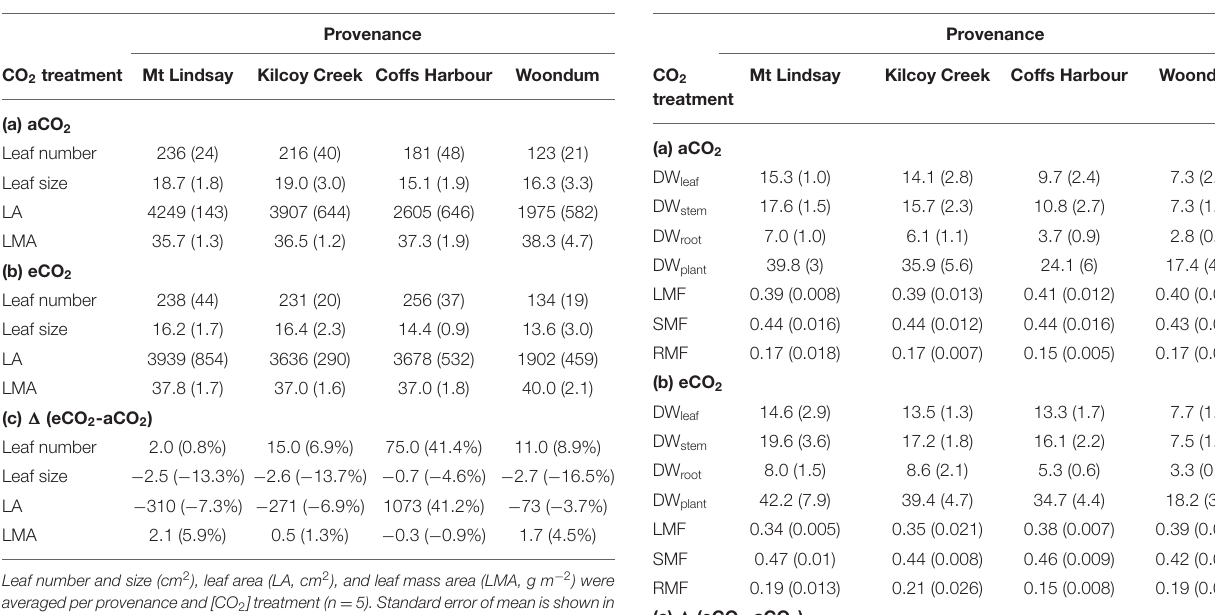
TABLE 2 | Leaf characteristics of E. grandis seedlings of Experiment 1 grown in ambient [aCO 2 ; (a)] and elevated [CO 2 ] [eCO 2 ; (b)].